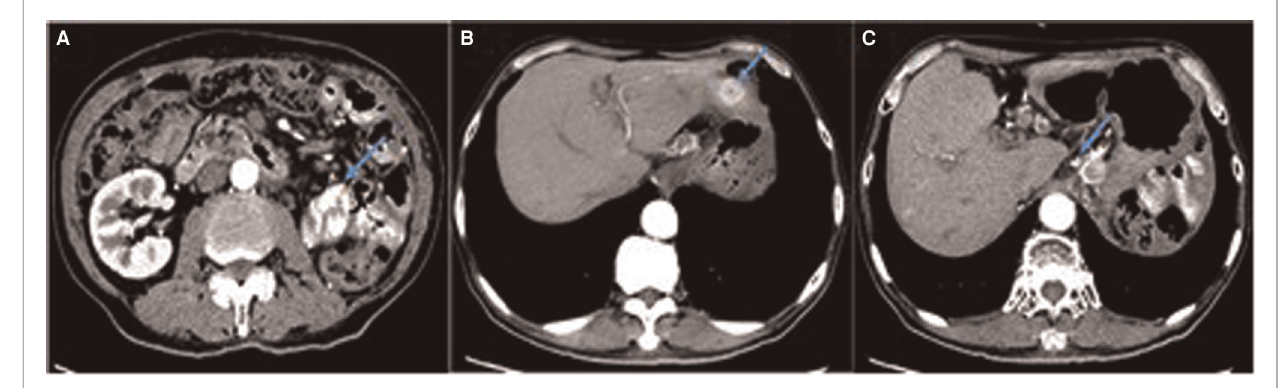
FIGURE 4 | Enhanced CT scan showing multiple abnormal enhancement lesions (arrows). ( A ) The mass with heterogeneous enhancement in left kidney area. ( B ) A ‘ target-like ’ sign and heterogeneous enhancement of the nodule in liver. ( C ) Multiple enlarged lymph nodes in hepatic